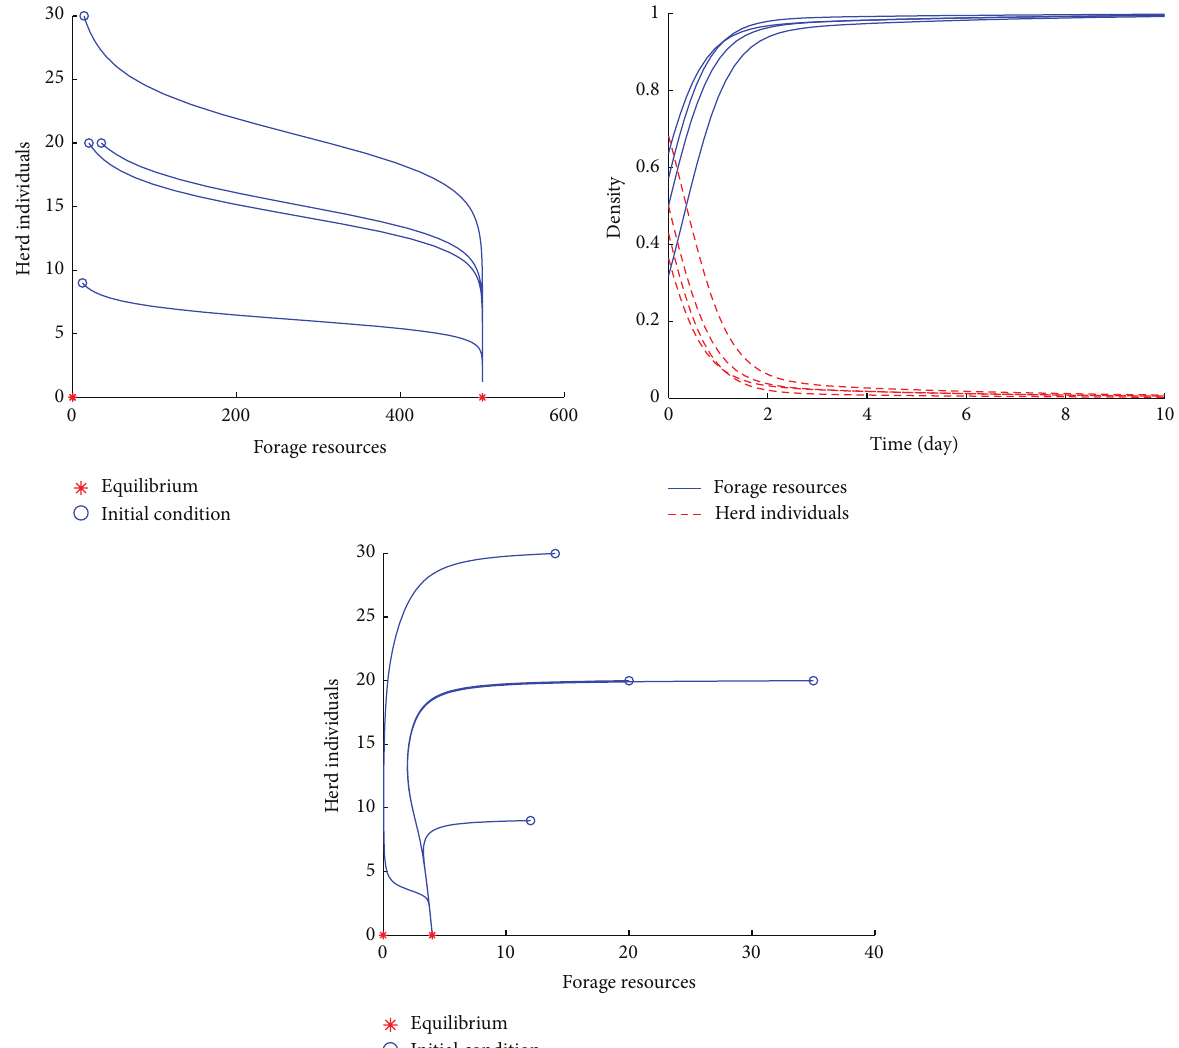
Figure 3: Chronological evolution and phase portrait of the herd individuals and forage resources of System (1) when 𝑟 01 = 200 kgDM/ha, = 55 kgDM/ha, 𝑟 = 80 kgDM/ha, 𝐾 = 30 – 600 kgDM/ha, 𝑒 = 0.05/ day, 𝑎 = 0.013/ ha, 𝑞 = 0.4/ day, and 𝛾 = 0.07/ day. Global stability of 𝑟 02 1 equilibrium 𝐸 1 = (𝐾,0) for System (1). This illustrates the case when pastoralists decide to migrate for reasons different from unavailability of forage